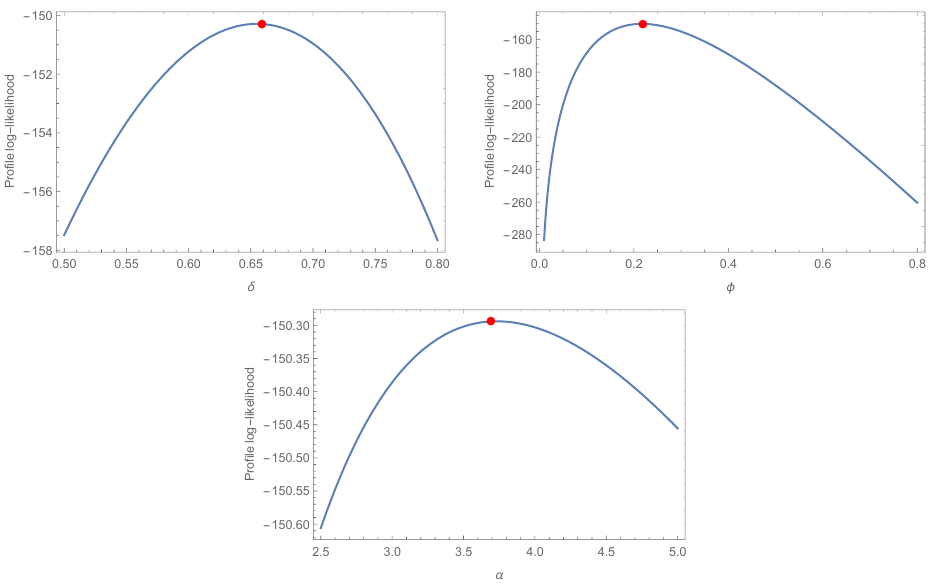
Figure 3. The profiles of the log-likelihood functions of ˆ δ MLE , ˆ φ MLE , and ˆ α MLE using the hydrological data set.